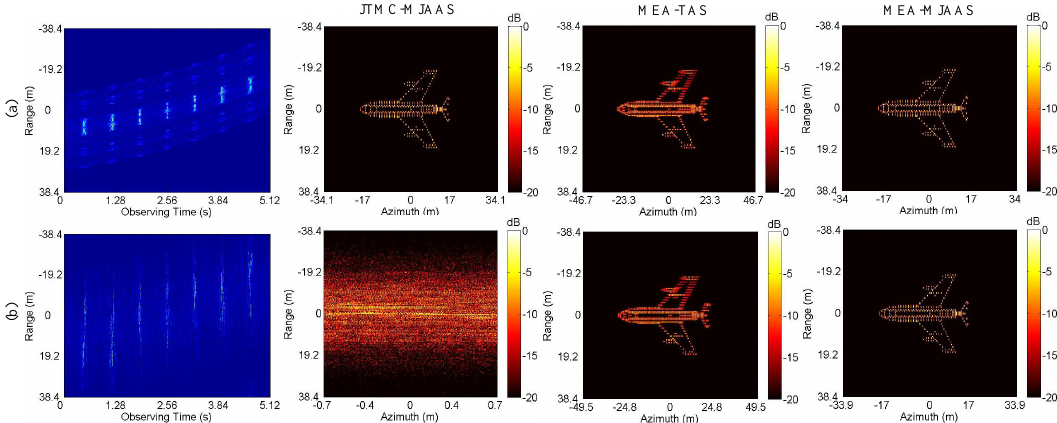
Figure 7. The imaging results of di ff erent algorithms corresponding to CM and NCM. ( a ) CM. ( b )